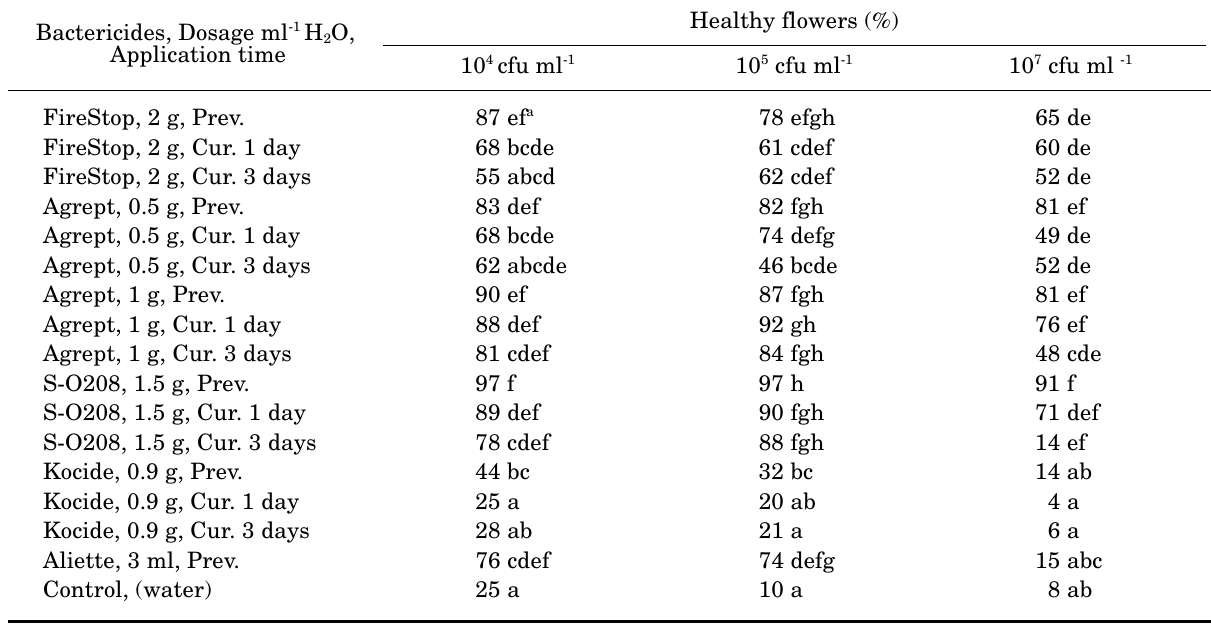
Table 4. Effectiveness of preventive (Prev.) and curative (Cur.) sprays on pear flowers (var. Kristalli) artificially inoculated with Erwinia amylovora at concentrations of 10 4 ,10 5 and 10 7 cfu ml -1 in 1994. Healthy flowers (%) O, Bactericides, Dosage ml -1 H 2